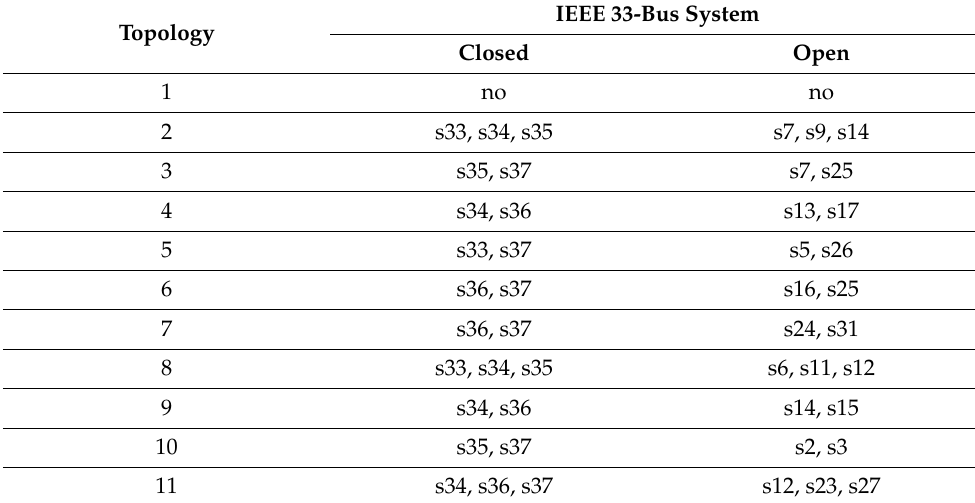
Table 5. The topological set of IEEE 33-bus system